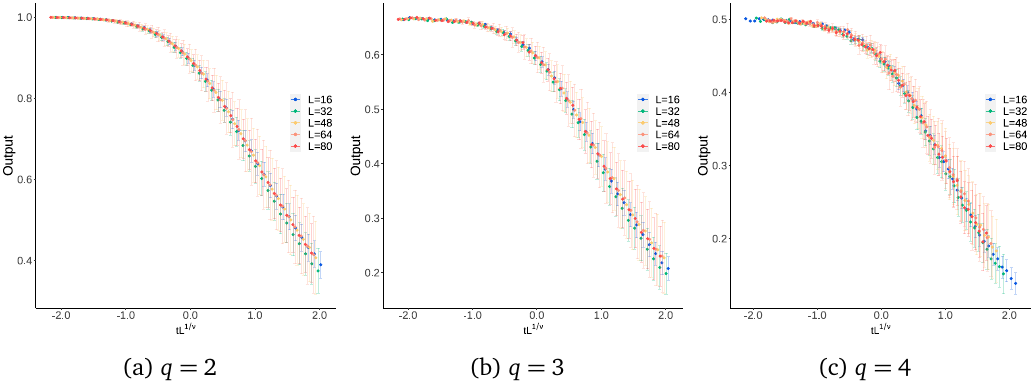
Figure 22: The finite-size scaled plots of the average output of an ensemble of 10 independently trained ANNs – training with simplified data, and testing with MC data of the ferromagnetic q -state Potts model on a square lattice. The error bars shown are 99.7% confidence intervals of the ensemble average.